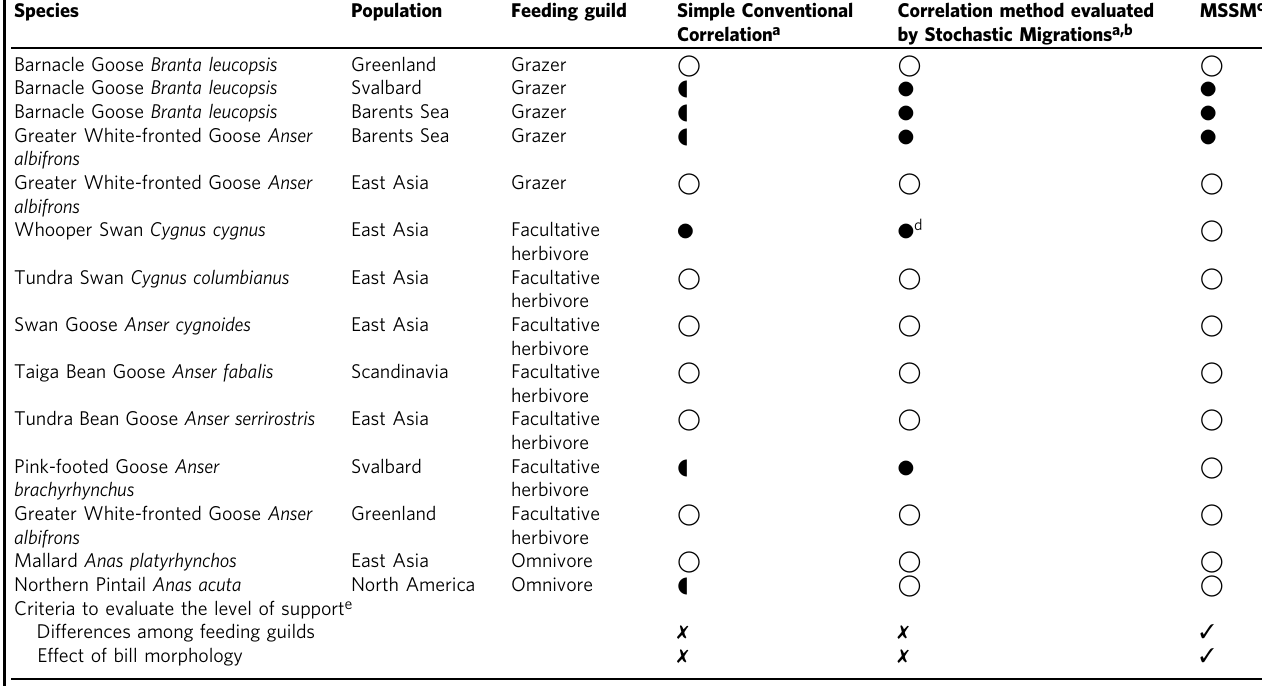
Table 1 Comparison of three different methods for assessing the level of support for the green wave hypothesis